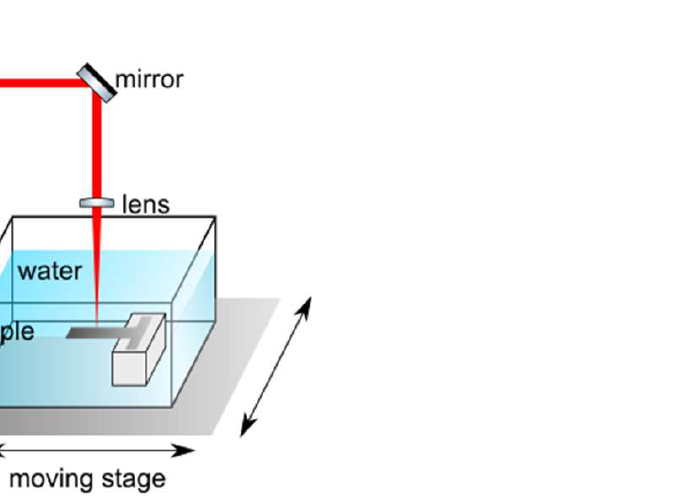
Figure 1. Experimental setup and laser scanning. A moving stage moves the container in the X and Y directions, so the focused Gaussian beam works on the cantilever section of the sample, which is submerged in water (confining medium).